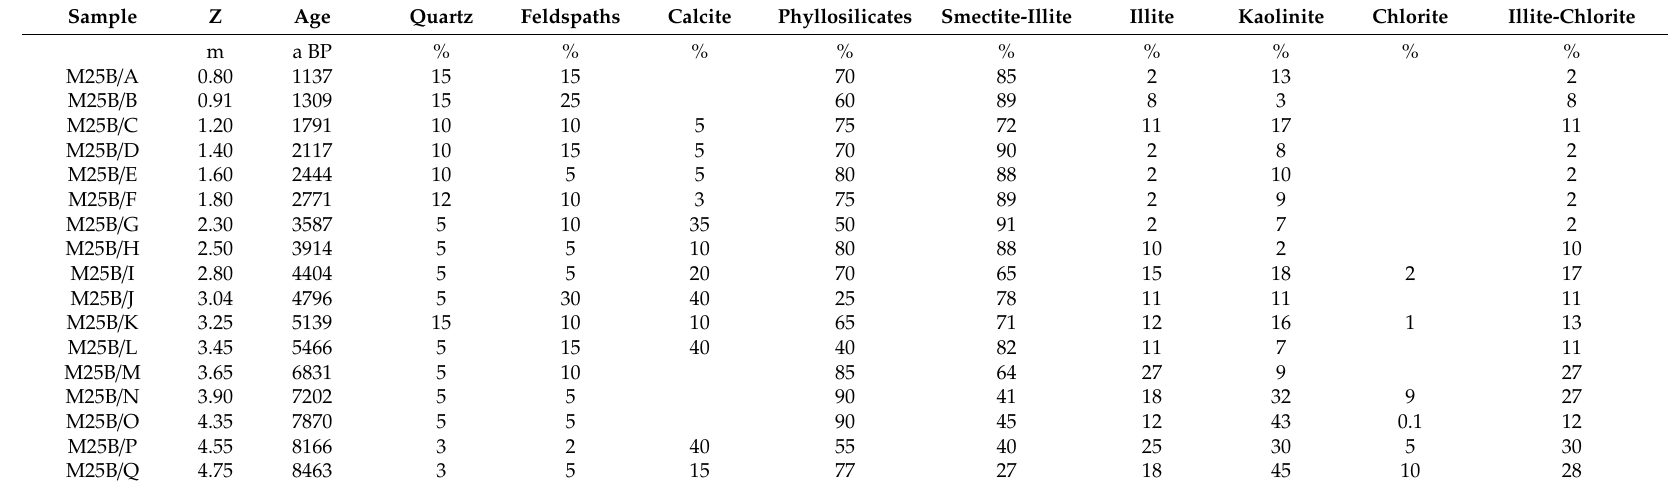
Table 1. Semi-quantitative X-ray di ff raction (XRD) analysis of the sediment in the M25B core. Radiocarbon dates are issued from the interpretation given by [12].